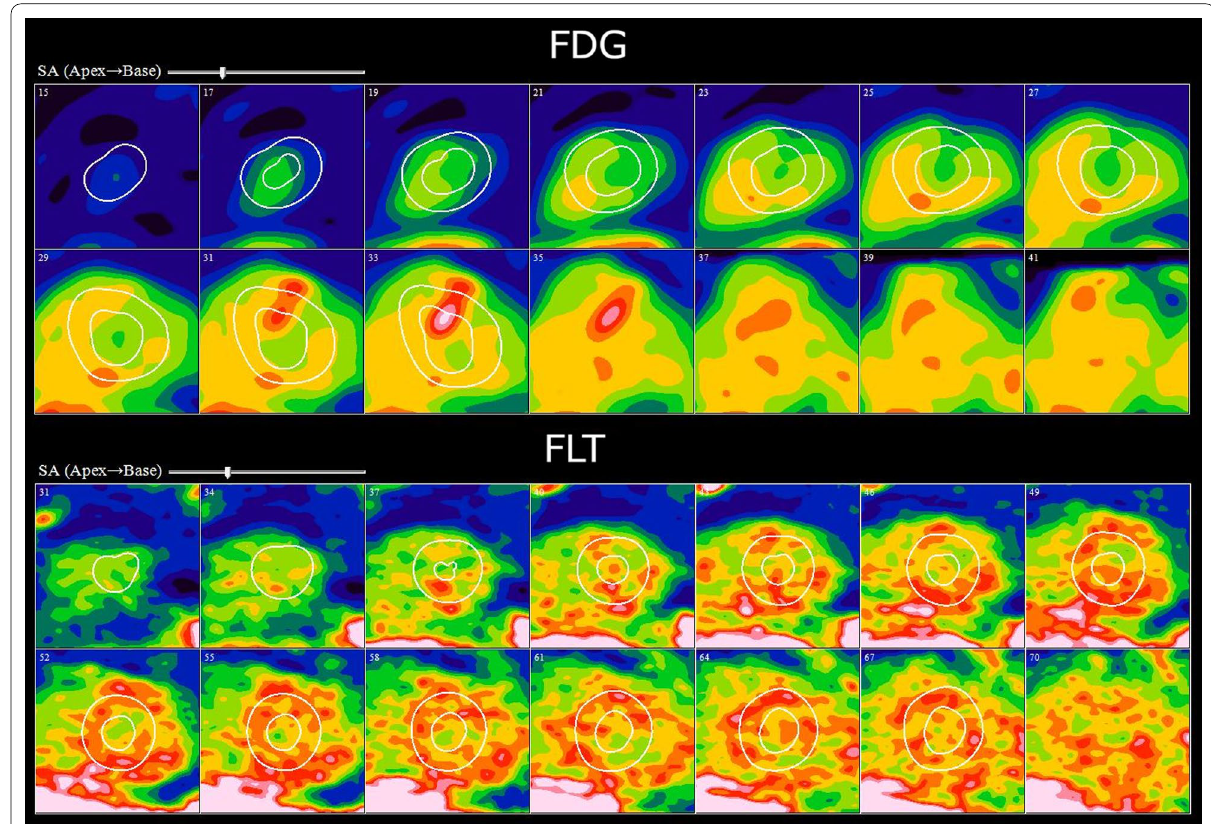
Fig. 3 Cardiac short axis views of subject #10 demonstrating a focus of myocardial uptake in the basal anterior wall on FDG‑PET (top) without corresponding uptake on the FLT‑PET study (bottom). The diffuse heterogeneous uptake seen on the FLT study is in keeping with background blood pool uptake